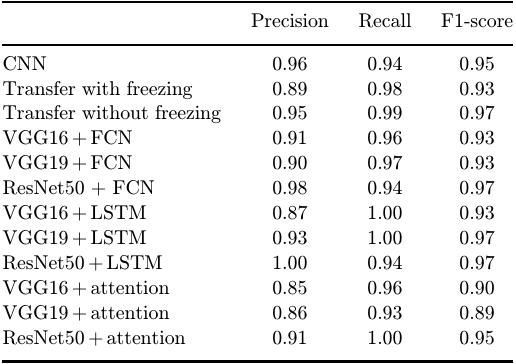
Table 6. Classi¯cation report of the non-violent class.